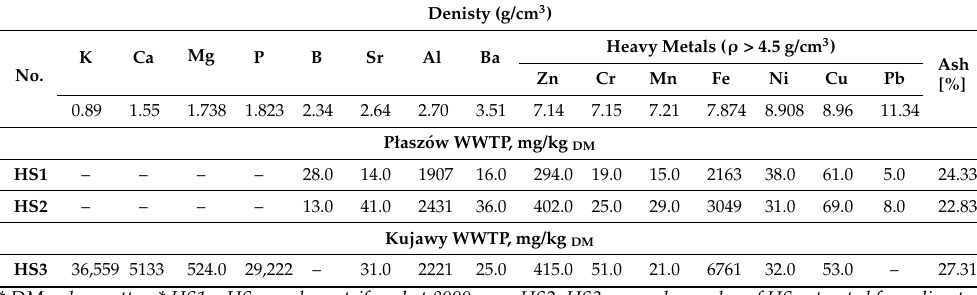
Table 6. Inorganic micropollutants in the HS extract centrifuged at 4000 and 8000 rpm. Denisty (g/cm 3 )